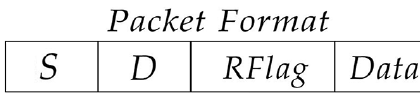
Figure 2. Packet format.